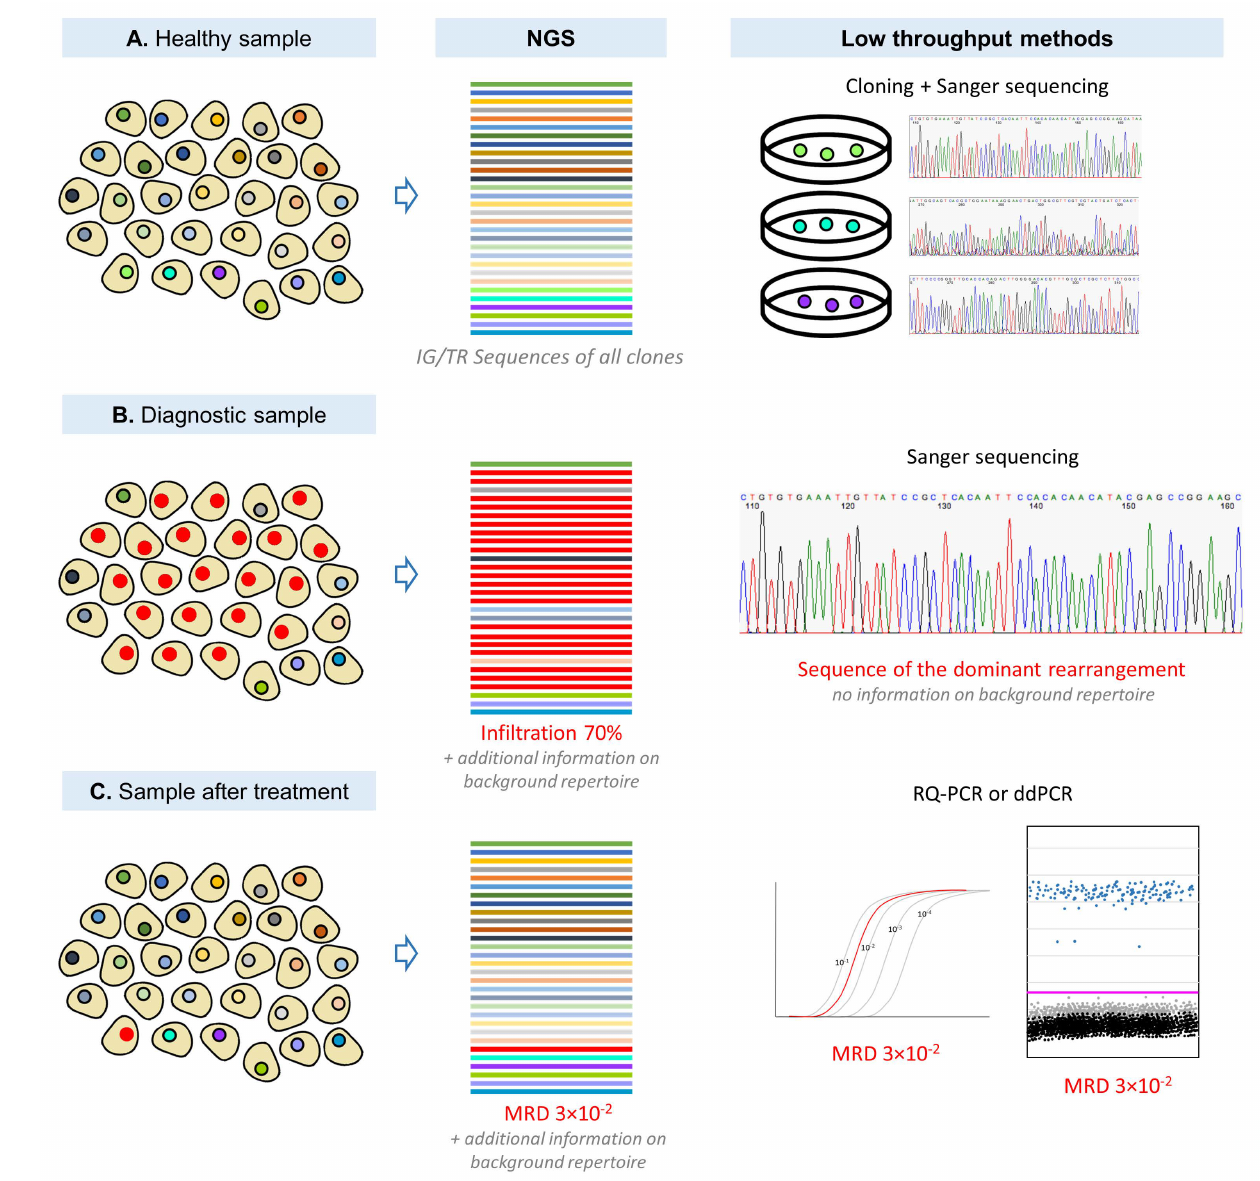
Figure 1. Low- and high-throughput (NGS) IG/TR analyses in different sample types. ( A ) In samples from healthy individuals, NGS provides sequences of all clones. These can also be obtained by low-throughput Sanger sequencing, but it is necessary to clone the PCR products before sequencing to obtain a clean sequence of each clone separately. ( B ) In highly infiltrated diagnostic samples, NGS provides a sequence of the dominant malignant clone (red) and background clones, as well as information on their abundance. Sanger sequencing provides a sequence of the dominant rearrangement only, without abundance information. ( C ) In samples after treatment, NGS can detect the rearrangement of the malignant clone (red) and the background rearrangements. RQ-PCR or ddPCR only provide the information about the MRD